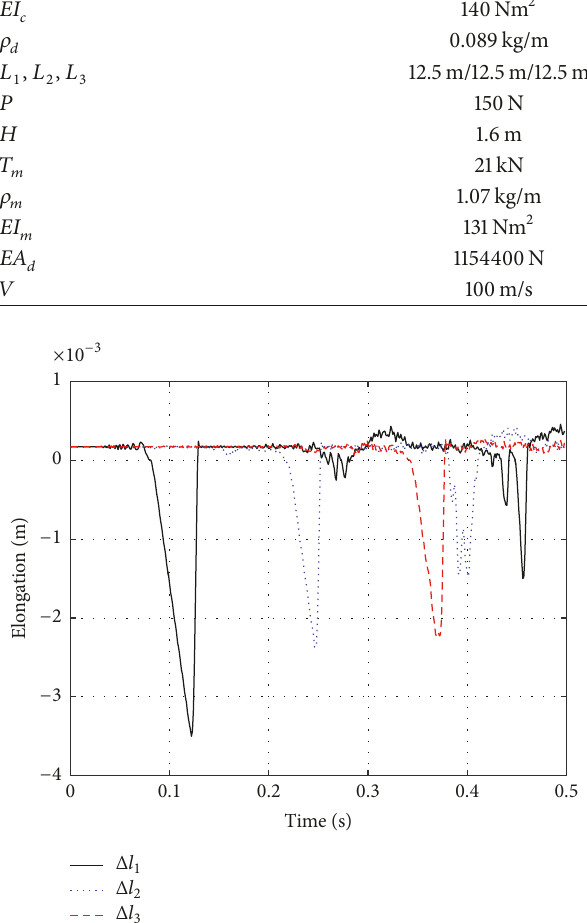
Figure 12: Time history of the elongation of